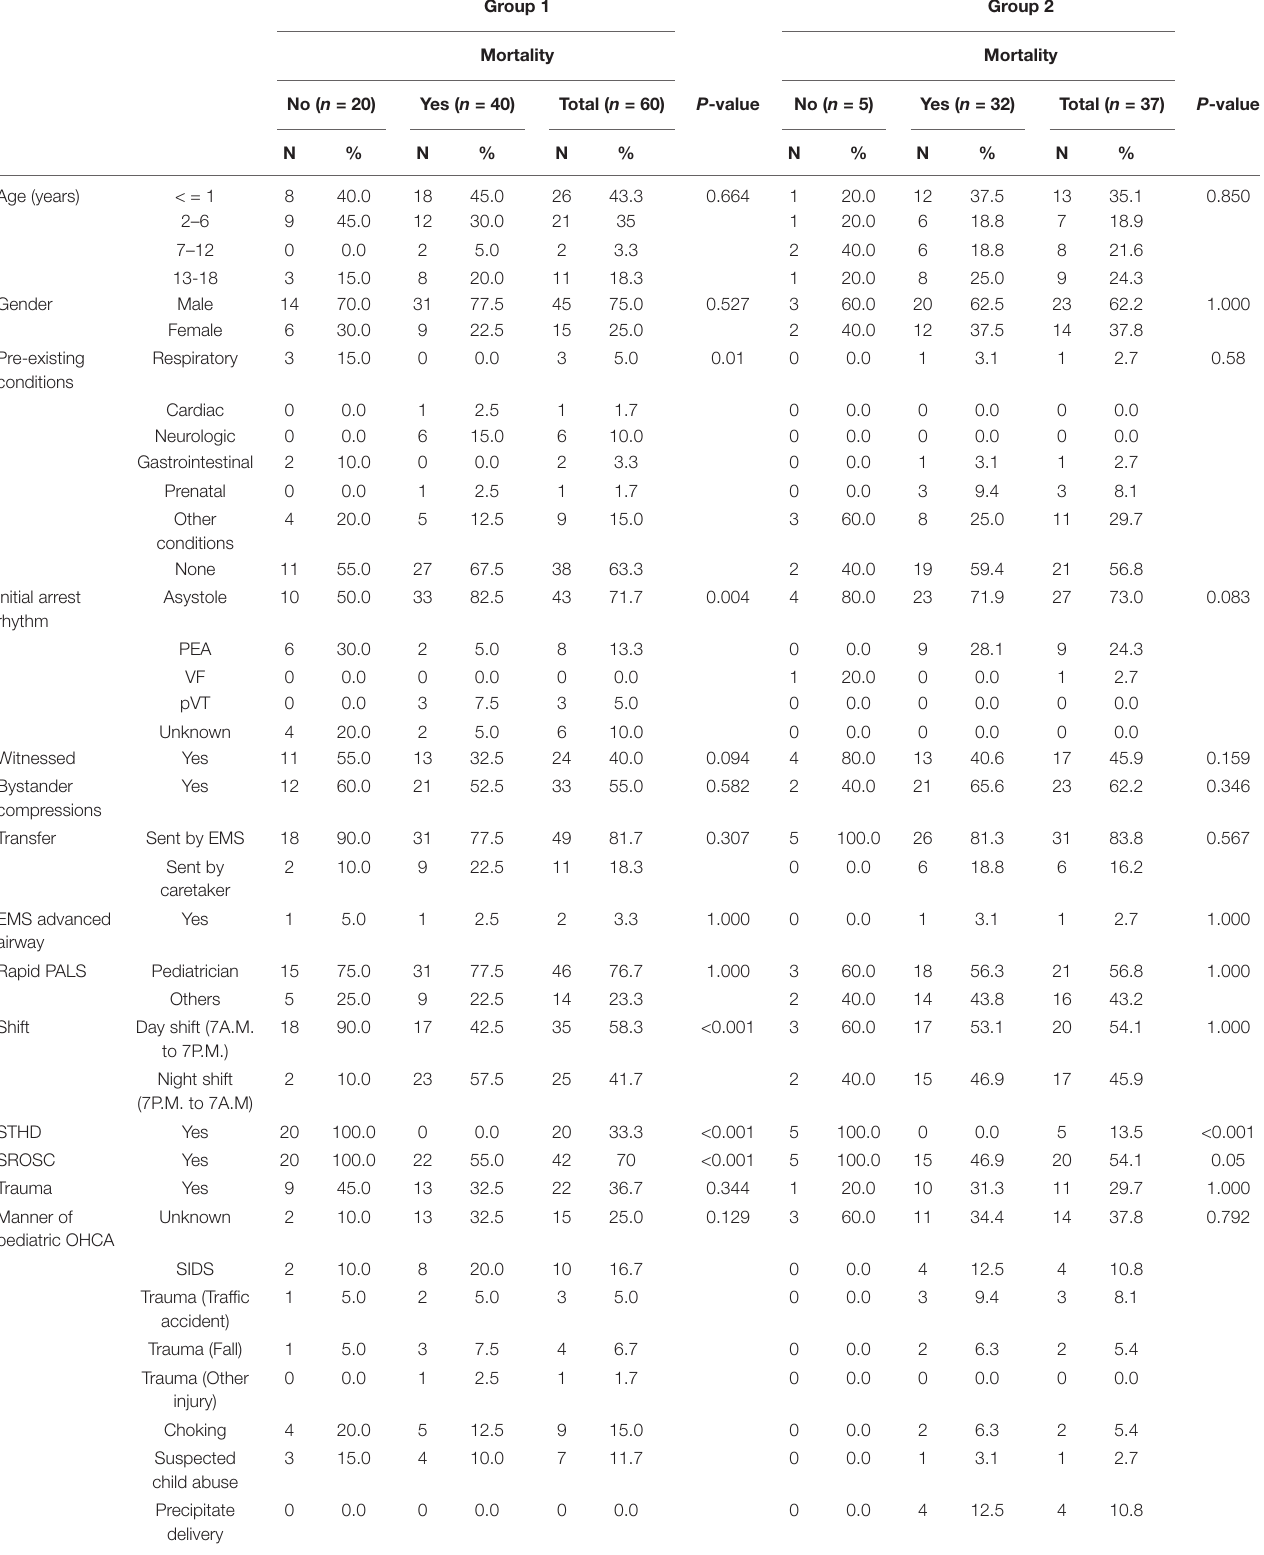
TABLE 4 | Comparison of child characteristics and associations with outcomes based on before or after pandemic.